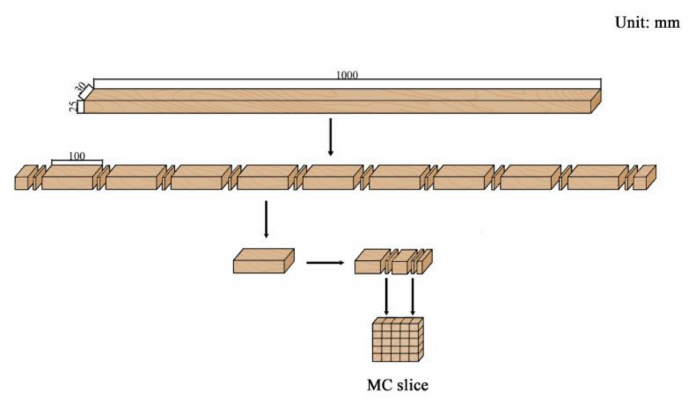
Figure 1. Schematic diagram of drying specimens